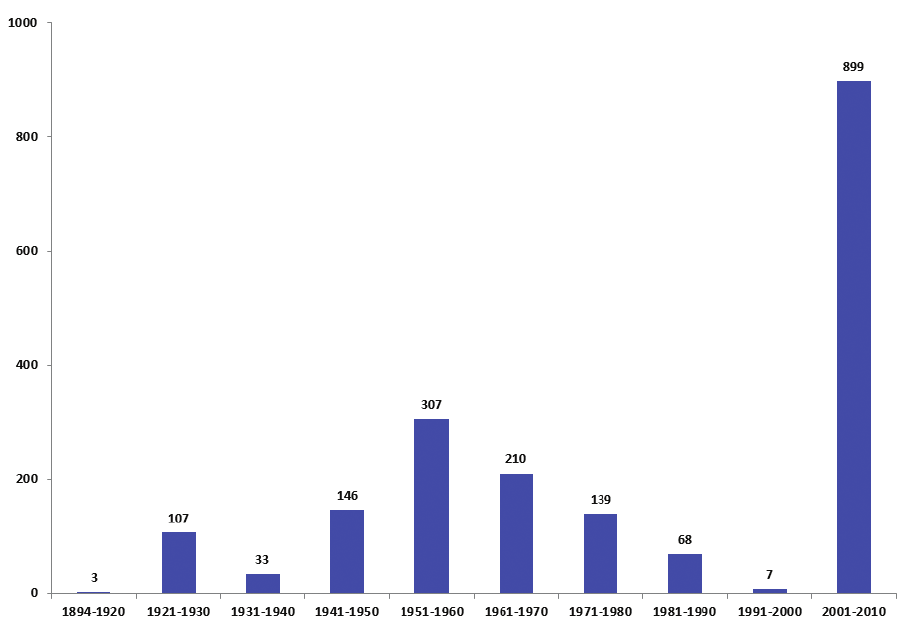
Figure 2. Specimens of Microgastrinae collected in Ottawa by decade (1894–2010). Data based on CNC holdings